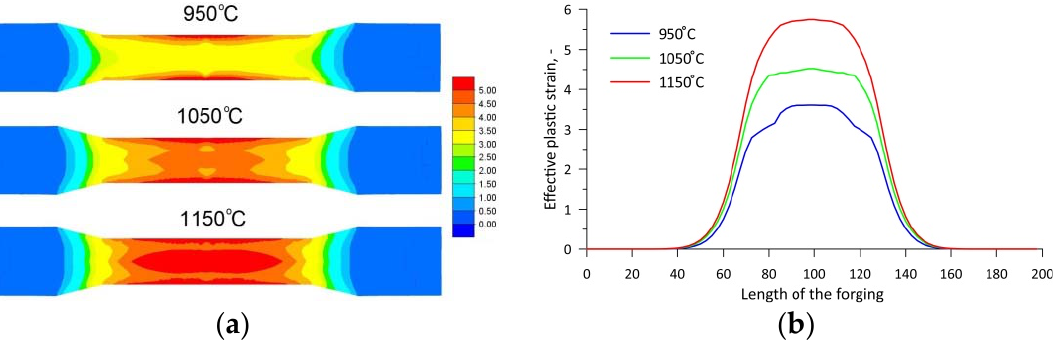
Figure 9. Effective plastic strain values at different rolling temperatures: ( a ) distribution map in the axial section; ( b ) distribution along the central axis of the forgings.